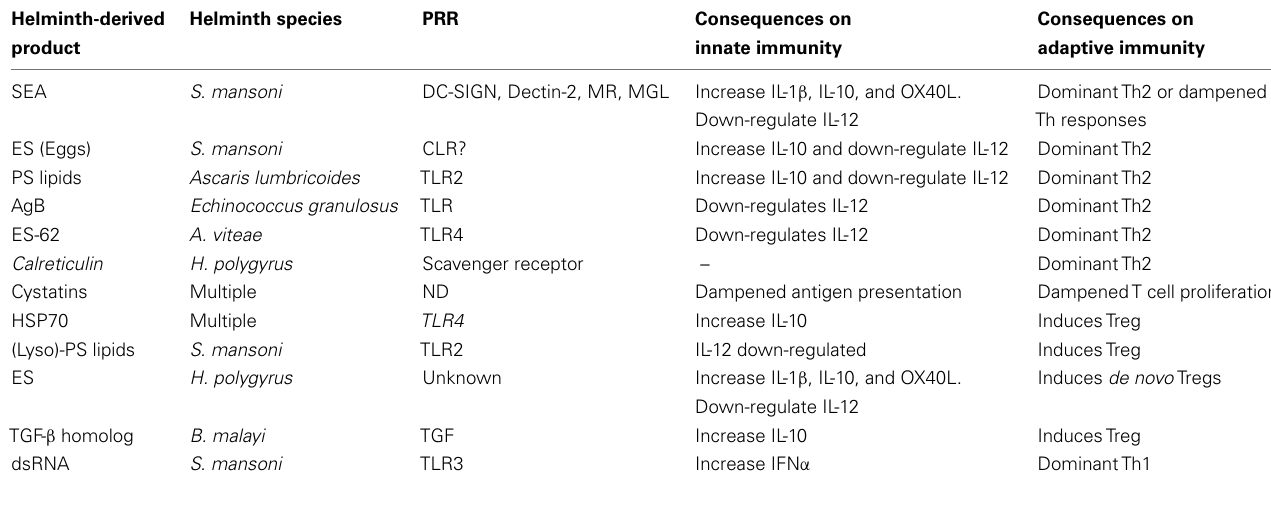
Table 1 |An overview of selective helminth-derived products, their innate cell signaling component, and the effects they have on the adaptive immune